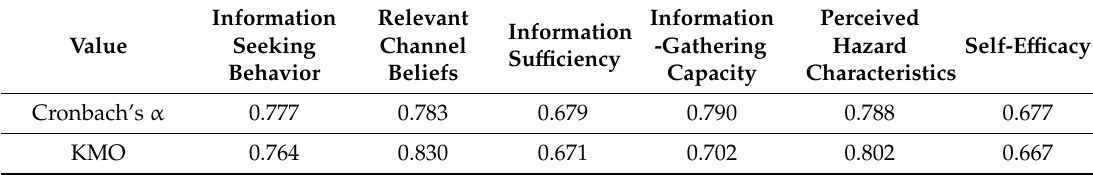
Table 2. Summary of exploratory factor analysis and reliability analysis.